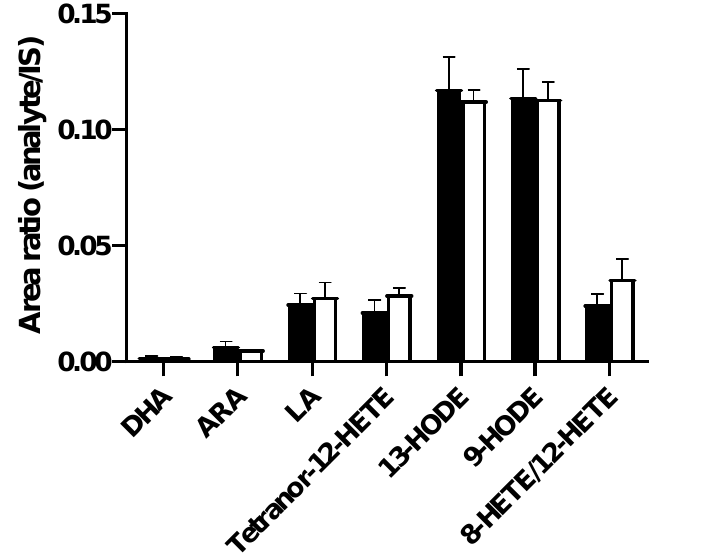
Figure 3. Increased sample volume for protein precipitation using MeOH*BHT/H 2 O*ZnSO 4 (80:20 v / v ) did not show any significant improvements in signal intensities, expressed as peak area ratios of analyte to IS after correction for dilution effects. Measurements performed as triplicates. Statistics: